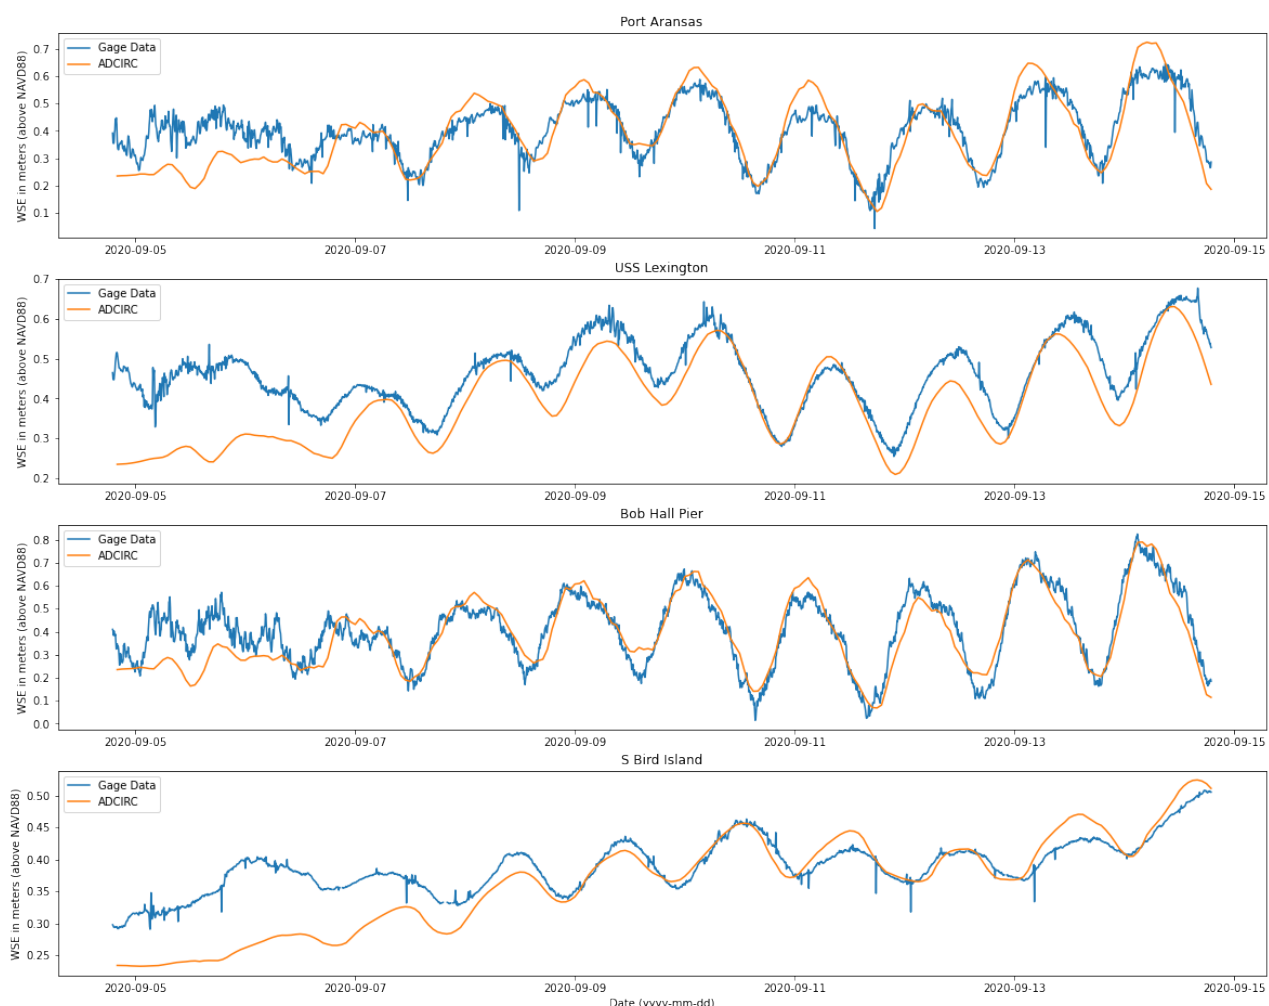
Figure 7. Water surface elevations in ADCIRC compared to nearby NOAA gauges during September 2020 for